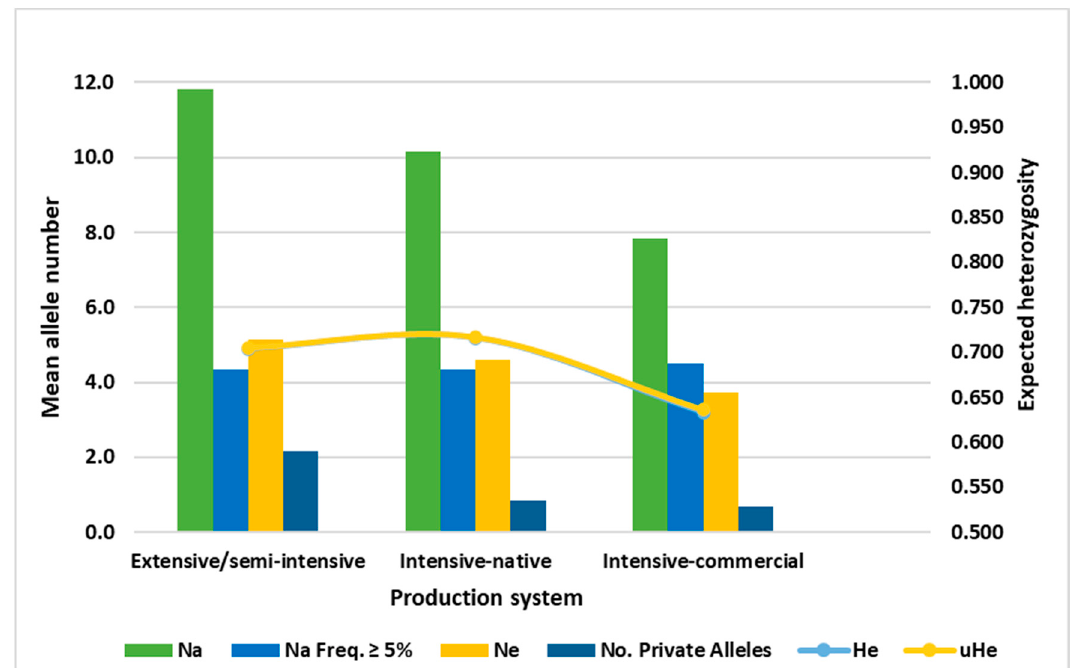
Figure 3. Mean allelic patterns of Set 2 microsatellite markers across the populations grouped based on their production systems. Na: number of different alleles; Ne: mean number of effective alleles; Na. Freq. ≥ 5%: number of alleles with more than 5% allele frequency; H e : expected heterozygosity and uH e : unbiased expected heterozygosity. Table 5. Allele number and allele richness and unbiased expected heterozygosity difference for Set 2 MS markers in chicken populations grouped by their production systems.